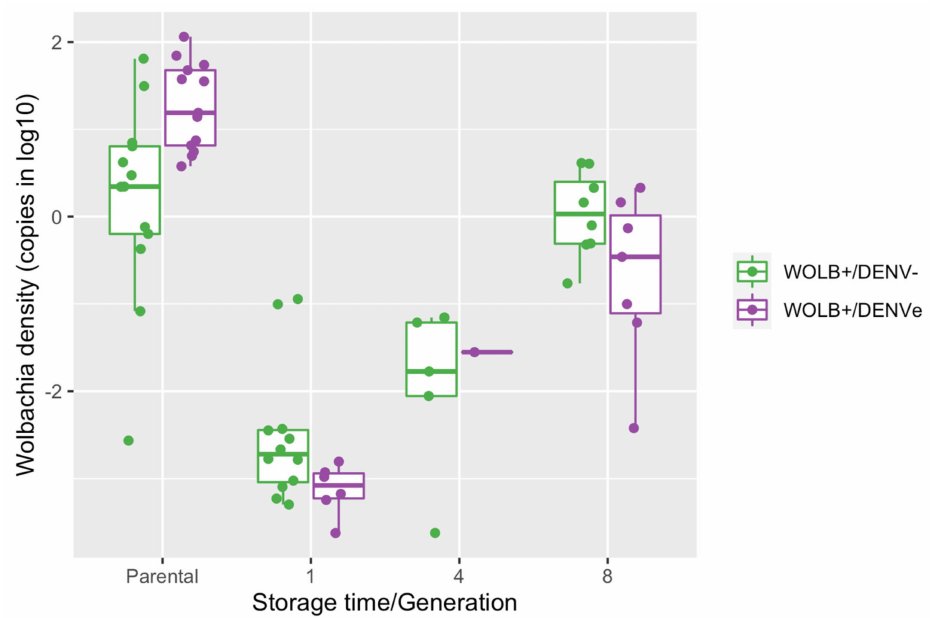
Figure 8. Wolbachia density in females reared from quiescent eggs laid by WOLB+/DENVe and WOLB+/DENV − Ae. aegypti and stored for one, four and eight weeks and in parental mosquitoes. Each dot represents an individual mosquito from WOLB+ parental and stocked